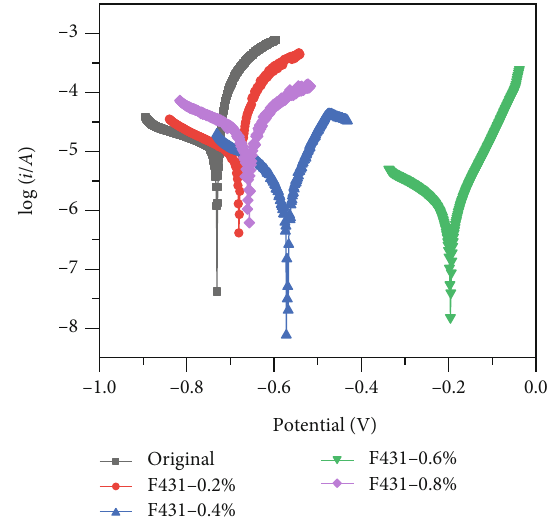
Figure 3: Tafel curves of original and graphene additions of 0.2%, 0.4%, 0.6%, and 0.8% anticorrosion coatings. Original, no graphene